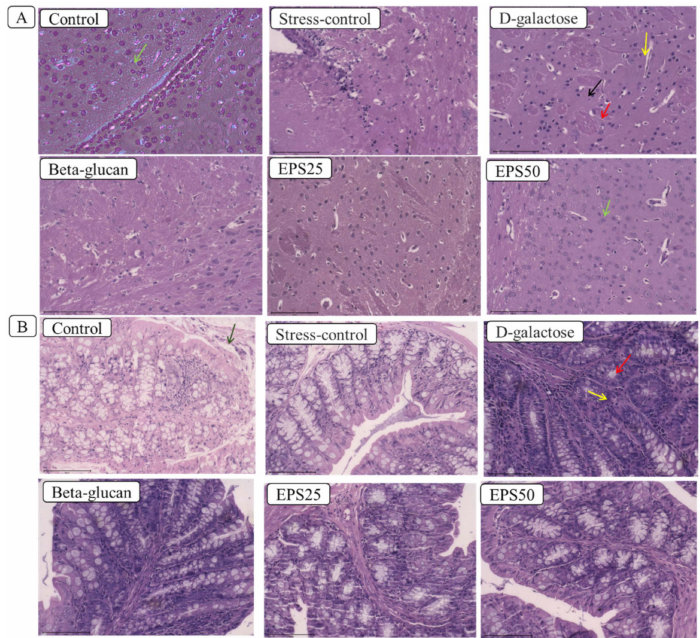
Figure 1. Effects of EPSRam12 on morphology of brain and colon tissue in D-galactose-induced mice. ( A ) Images of mouse brain slices stained with H and E: (Yellow arrow—disorganized nerve fibers, black arrow—irregular and reduced neuron number, red arrow—vacuolar changes in cytoplasm); ( B ) images of mouse colon slices stained with H and E: (Green arrow—intact epithelial layer architec- ture, red arrow—goblet cell depletion, yellow arrow—inflammation with infiltrating